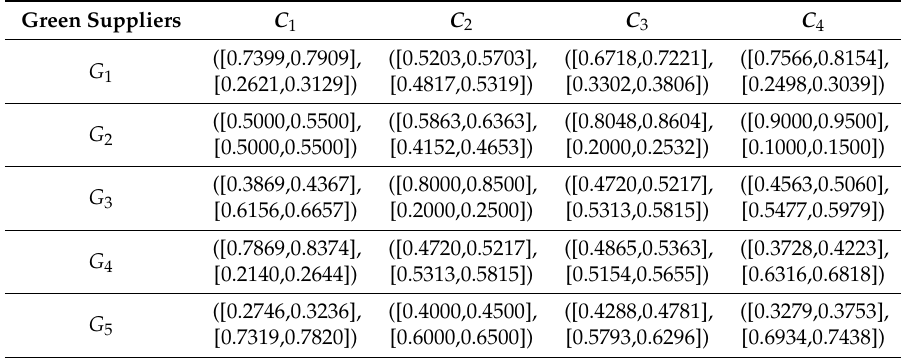
Table 3. Subgroup evaluation matrix R 1 .